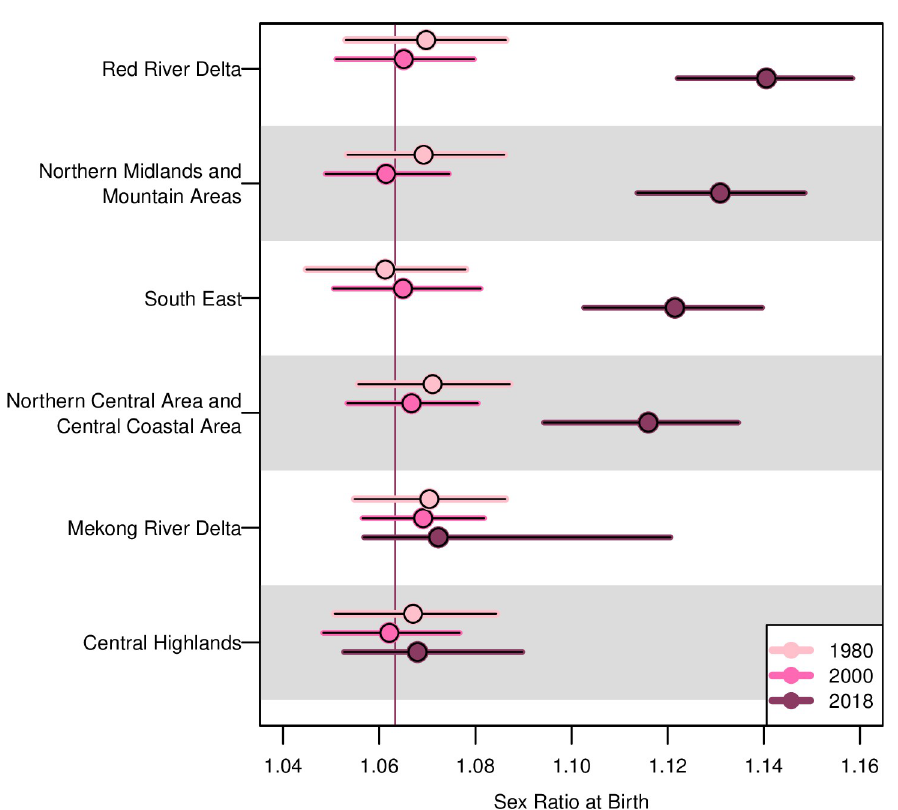
Fig 2. SRB estimates by Vietnam regions in 1980, 2000, and 2018. Median estimates are in dots. 95% credible intervals are in horizontal bars. The SRB national baseline for Vietnam as a whole is indicated by the vertical line at 1.063. The country’s regions are shown in descending order of the 2018 median estimates.